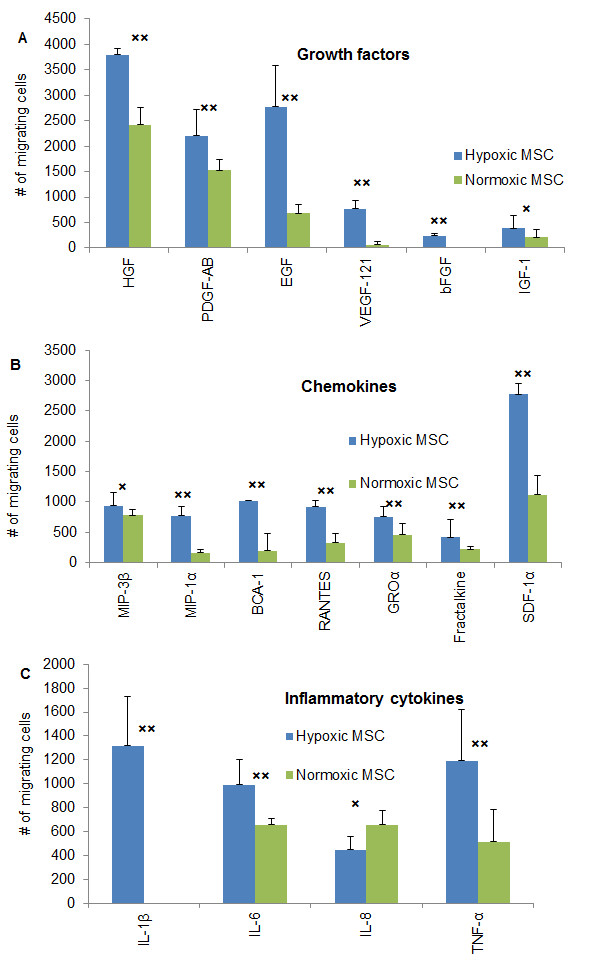
Migration capacity of hypoxic and normoxic hMSCs towards growth factors, chemokines and inflammatory cytokines. In vitro migration was assayed in transwell plates with porous polycarbonate membranes (pore size: 5 um). Columns represent the difference between the mean numbers of induced and spontaneously migrating cells (no chemoattractant added). Each condition was tested in four wells; each experiment was repeated four times. The bars represent 1 SEM from four independent experiments combined (n = 16). × - P > 0.05, ×× - P < 0.05. (A): Migration of (BM) hMSC towards growth factors, (B): Migration of (BM) hMSC towards chemokines, (C): Migration of (BM) hMSC towards inflammatory cytokines. hMSC, human mesenchymal stem cells; SEM, standard error of the mean.